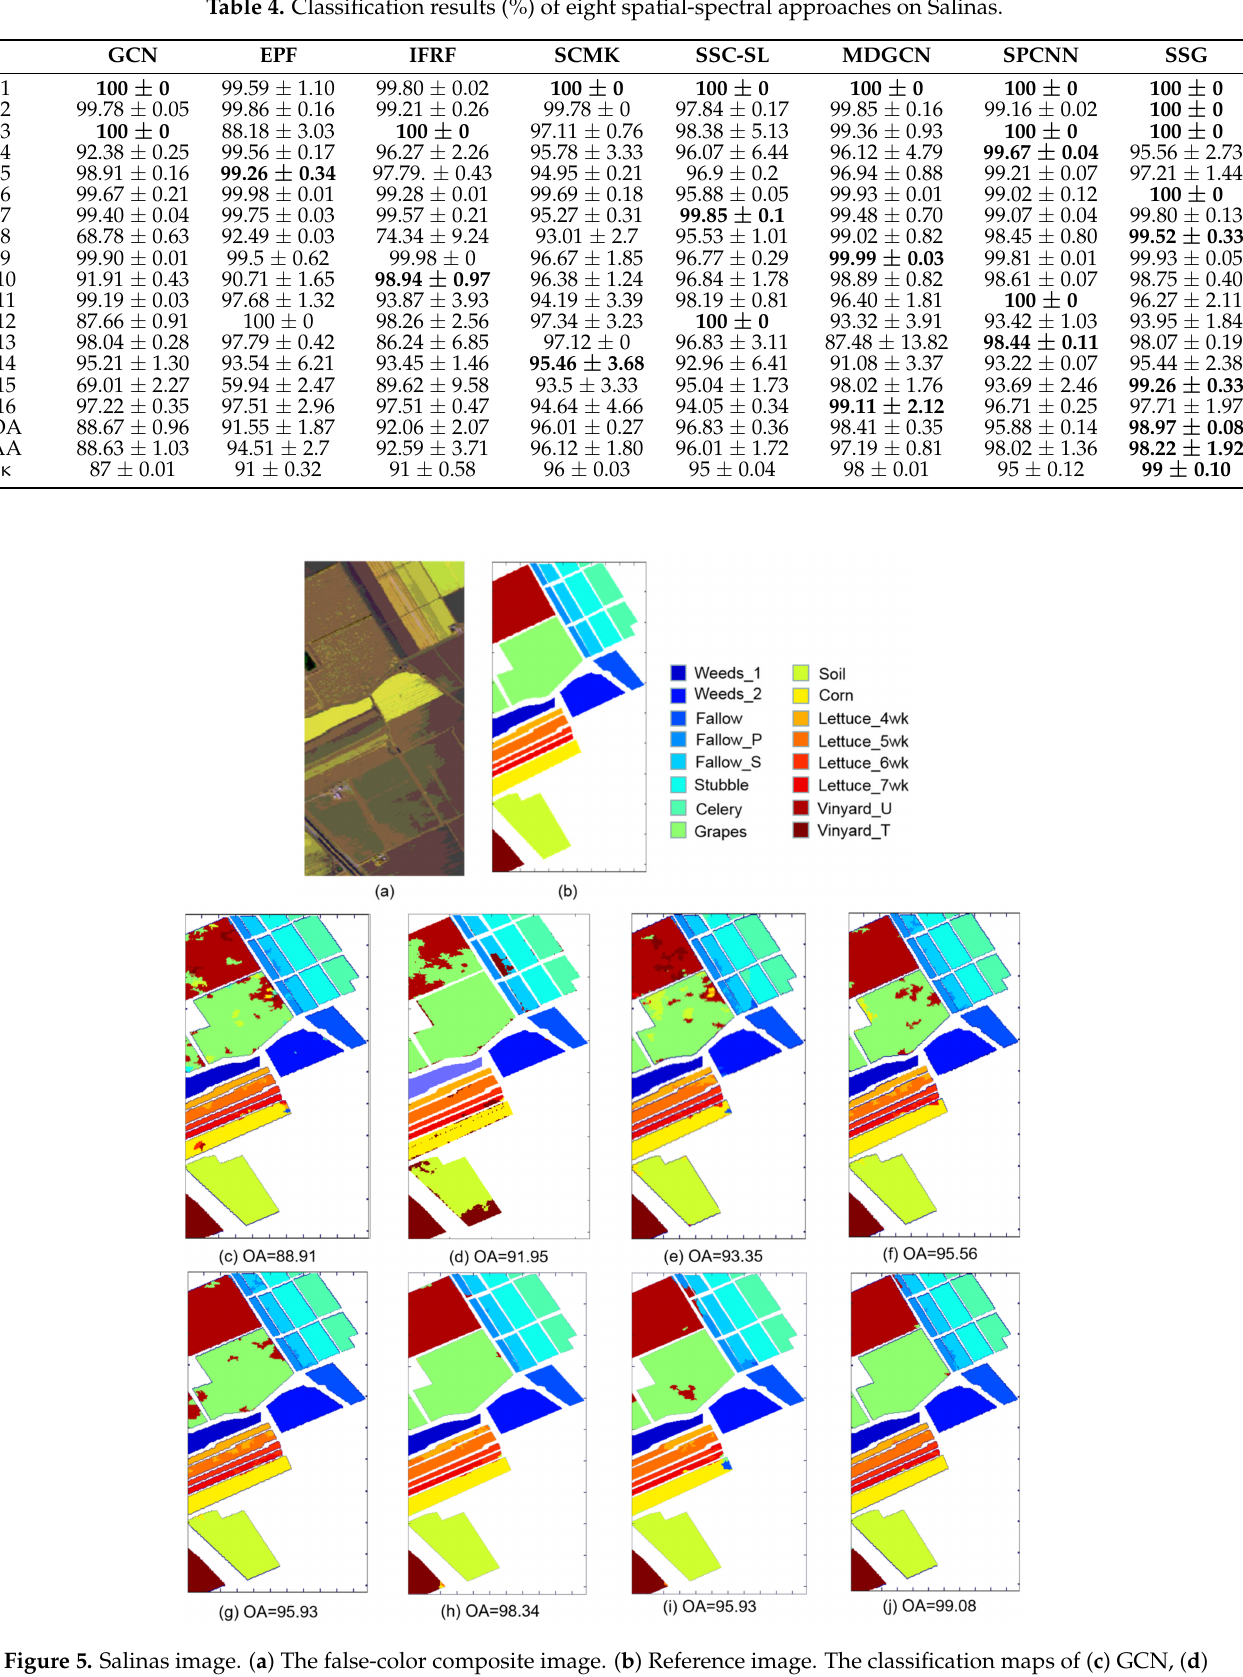
Figure 5. Salinas image. ( a ) The false-color composite image. ( b ) Reference image. The classification maps of ( c ) GCN, ( d ) EPF, ( e ) IFRF, ( f ) SCMK, ( g ) SSL-SL, ( h ) MDGCN, ( i ) SPCNN and ( j )